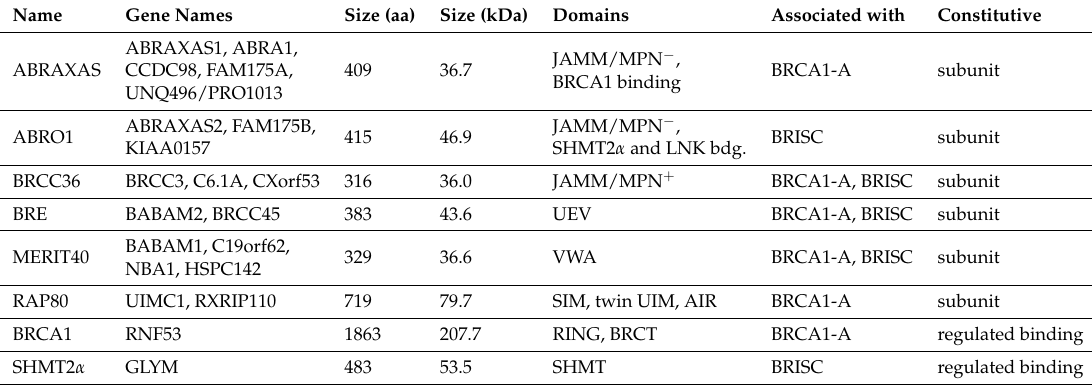
Figure 1. ( A ) Architecture of BRCA1-A and BRISC-SHMT2 α complex. Schematic representation of protein subunits and binding partners (BRCA1-A and BRISC-SHMT2 α structure: [25]). ( B ) Detailed view of the active site of BRCC36. The side chains of catalytic residues E33, D88, H122, H124, and D135 are shown. The zinc atom at the active center is shown in silver. A catalytic water molecule is shown as a blue sphere (BRCA1-A structure: [25]). ( C ) The BRCA1 BRCT dimer binds to the phosphorylated C-terminus of ABRAXAS. The flexible C-terminus of ABRAXAS is depicted schematically and the conserved BRCT binding sequence of ABRAXAS is shown. The phosphorylation sites at S404 and S406 are indicated with red dots. The BRCA1 BRCT domain dimer bound to the phosphorylated ABRAXAS C-terminus is shown in surface representation with the BRCA1 shown in pink and the ABRAXAS C-terminal tail in white with phosphorylation sites shown in red (BRCA1 BRCT structure: [30], BRCA1-A structure: [25]). Table 1. Subunits of BRCA1-A and BRISC complex, and binding